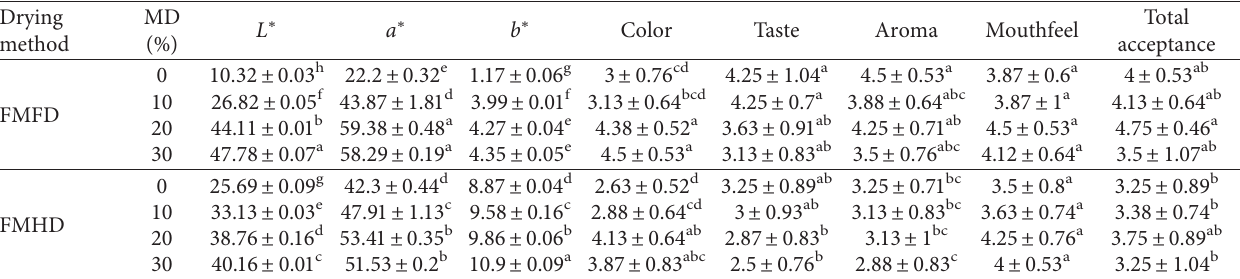
Table 2: Effects of different drying methods and MD levels on color values ( L ∗ , a ∗ , and b ∗ ) of foam-mat-dried instant beverage powders based on red beetroot extract, and sensory properties of the prepared beverages. Drying